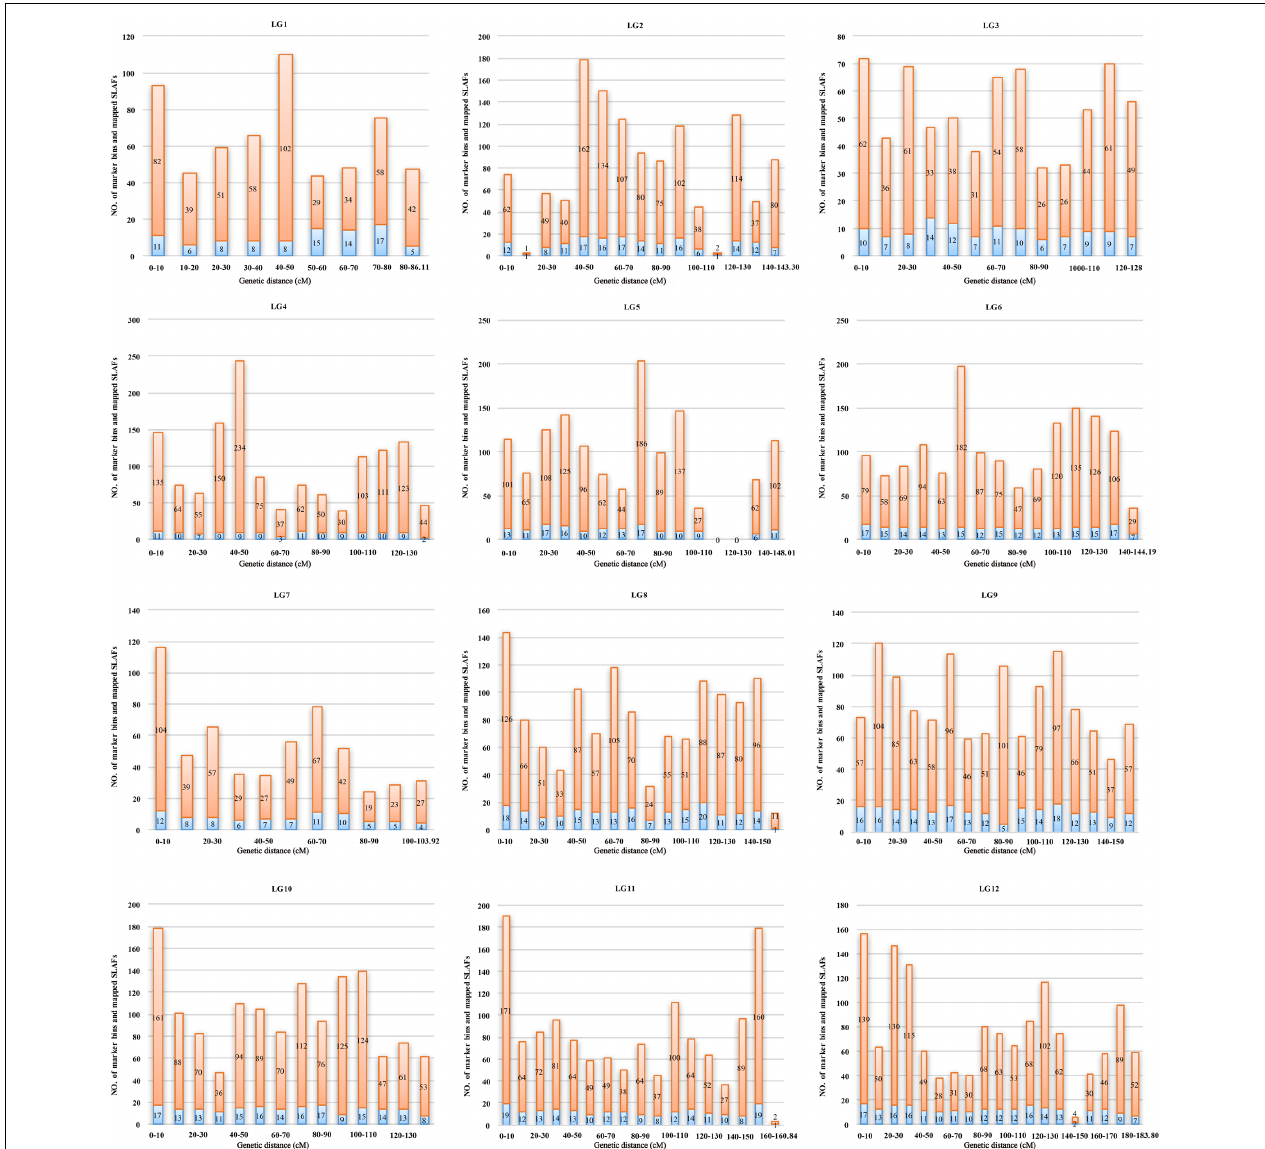
FIGURE 4 | Distribution of marker bins and SLAFs in the 10 cM sliding windows among each linkage group. The number of marker bins and the number of mapped SLAFs were indicated with blue and orange bars,